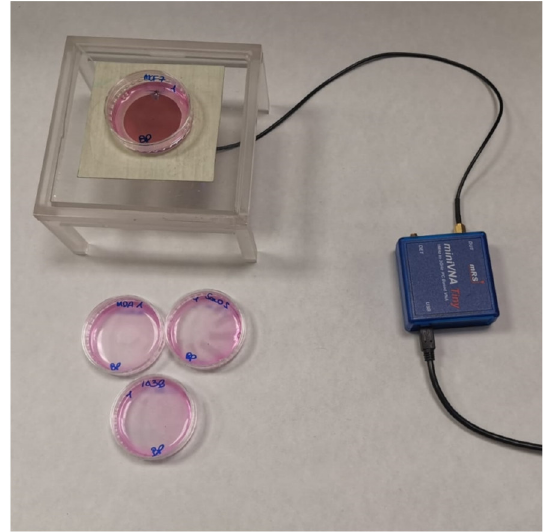
Figure 2. The experimental set-up comprises the circular biosensor, the network analyzer, and the Petri dish.